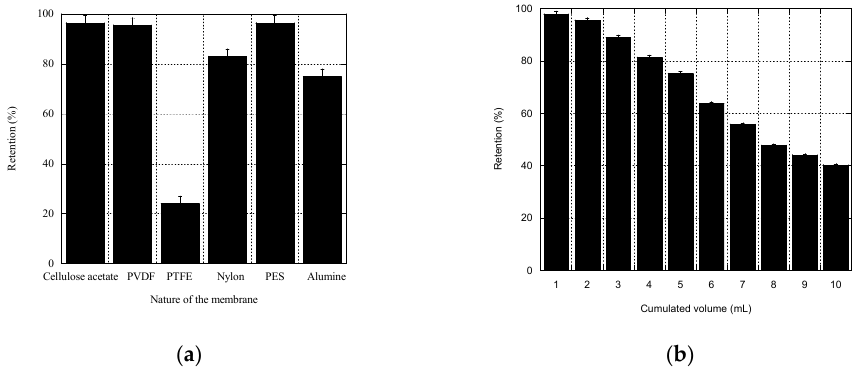
Figure 4. Percentage of retention for a solution of ε Vin (40 µg mL − 1 ) passing through syringe fil- ters. ( a ) Filters differing in the nature of the membrane (filter pore 0.45 µm). ( b ) Polyvinylidene fluorine (PVDF) filter (5 µm pore-sized). Error bars were calculated by measurements on 4 different filters.